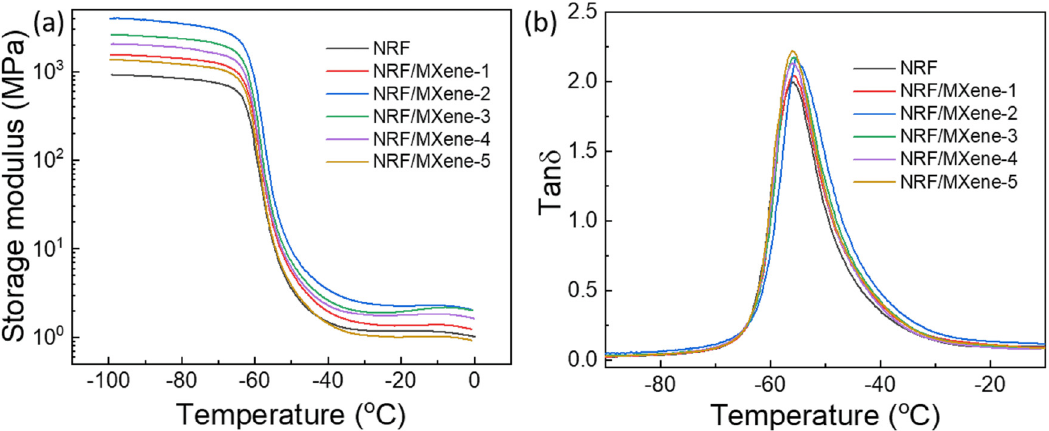
Figure 5: ( a ) Temperature - dependent curves of storage modulus ( E ′ ) and ( b ) temperature dependent curves of tan δ